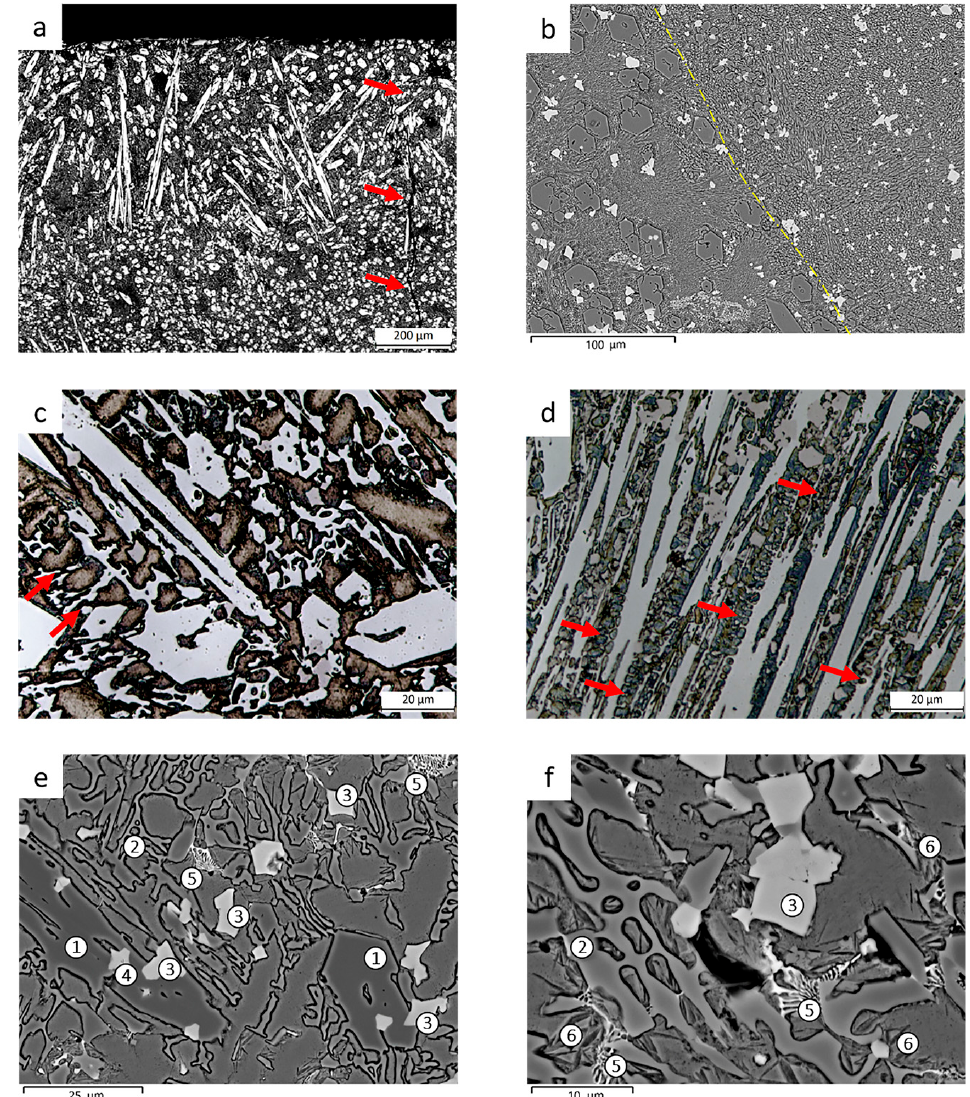
Figure 5. ( a ) Optical microscope (OM) micrograph of the T-section of the hardfacing captured from the resistant side, red arrows highlight the crack propagation path; ( b ) BSE-SEM image of the T-section at the boundary between two welding passes: the dash-dot yellow line separates the passes with coarser and finer rod-like carbides; ( c , d ) OM micrographs of the L-section in the substrate and resistant side, respectively; ( e , f ) BSE-SEM images of the T-section whit primary M 7 C 3 carbides (labeled as 1), eutectic ( γ + M 7 C 3 ) structure (labeled as 2), Nb-rich MC carbides (labeled as 3), Nb- and Mo-rich carbides (labeled as 4), Mo- and Fe-rich carbides (labeled as 5) and traces of martensite (labeled as 6).